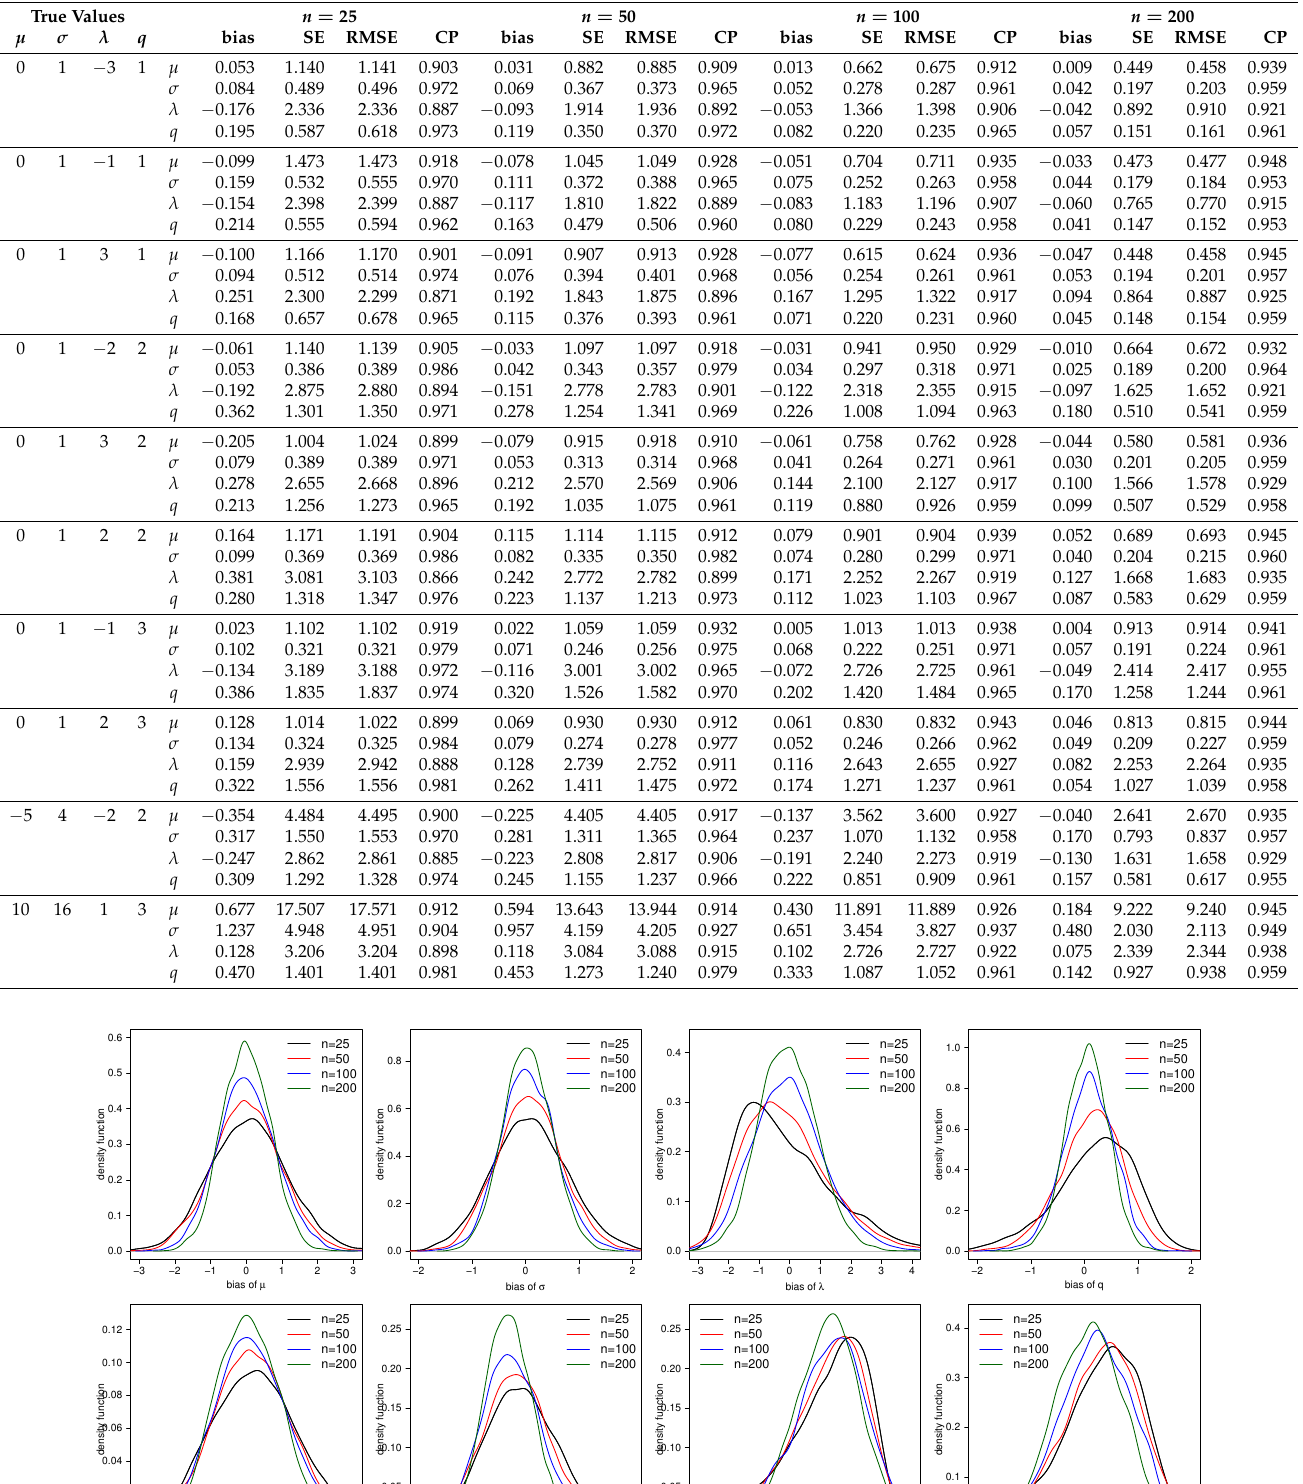
Table 1. Empirical bias, SE, RMSE, and 95% CP for the ML estimators of µ , σ , λ , and q with different combinations of parameters and sample sizes.